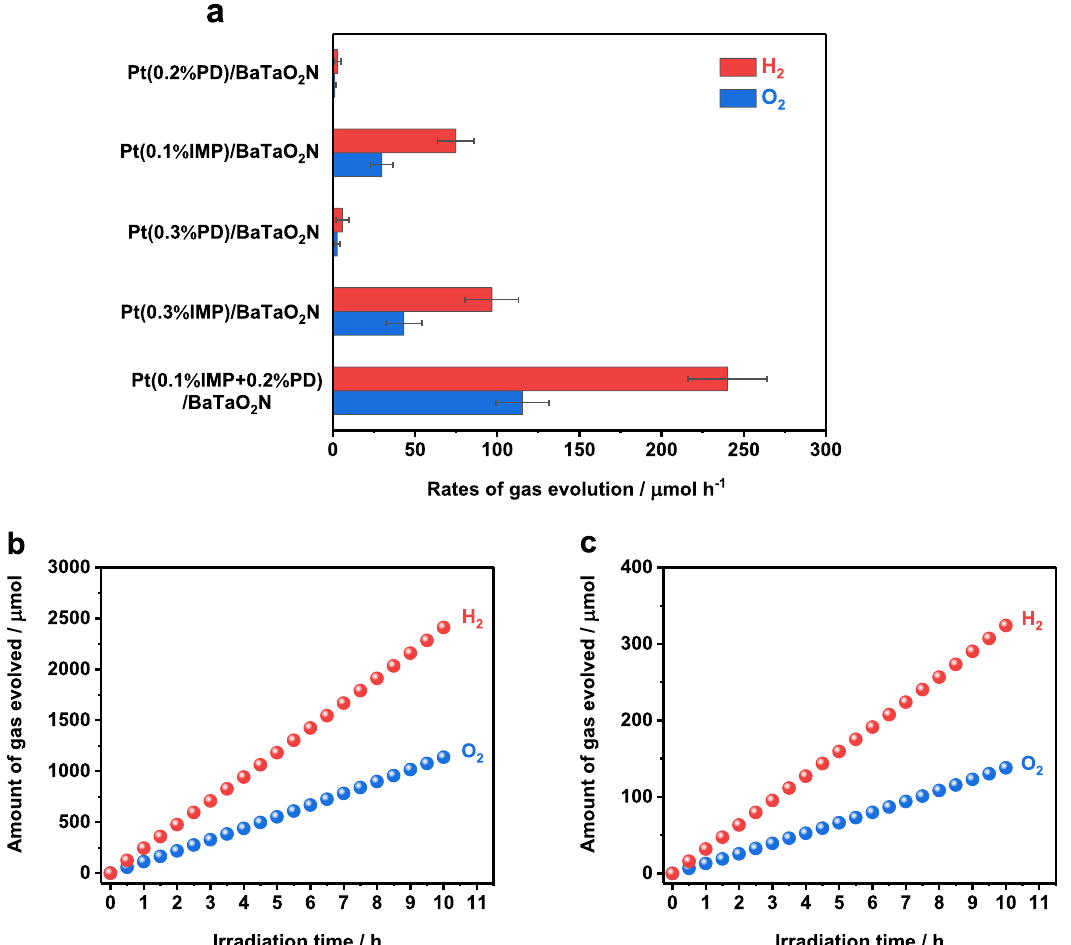
Fig. 5 Photocatalytic performance of Z-scheme water splitting. a H 2 and O 2 evolution rates during Z-scheme water-splitting reaction using Pt-modi fi ed BaTaO 2 N (RbCl) as the HEP. Error bars indicate standard deviation for three measurements. b , c Time courses of gas evolution during Z-scheme water- splitting reaction using Pt(0.1% IMP + 0.2% PD)/BaTaO 2 N as the HEP, under visible light ( λ ≥ 420 nm) ( b ) and simulated sunlight ( c ).